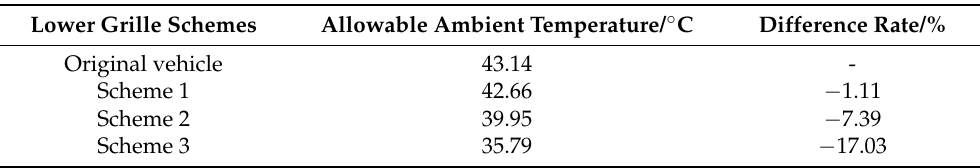
Table 8. Difference rate of allowable ambient temperature under different closure schemes of lower grille compared with the original vehicle.